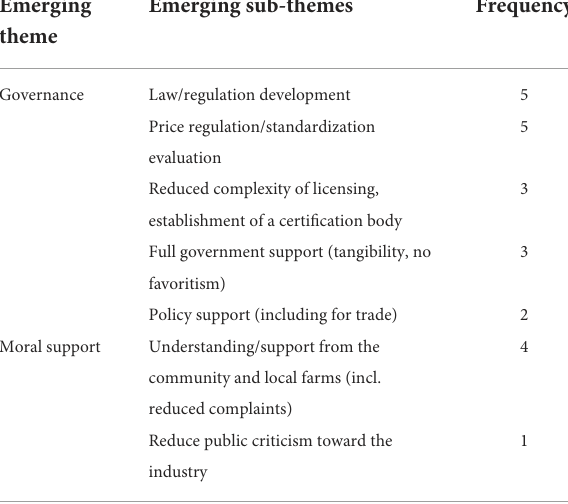
TABLE 5 Frequency of egg producers perception of the support that is needed when looking to adopt cage-free systems in across all